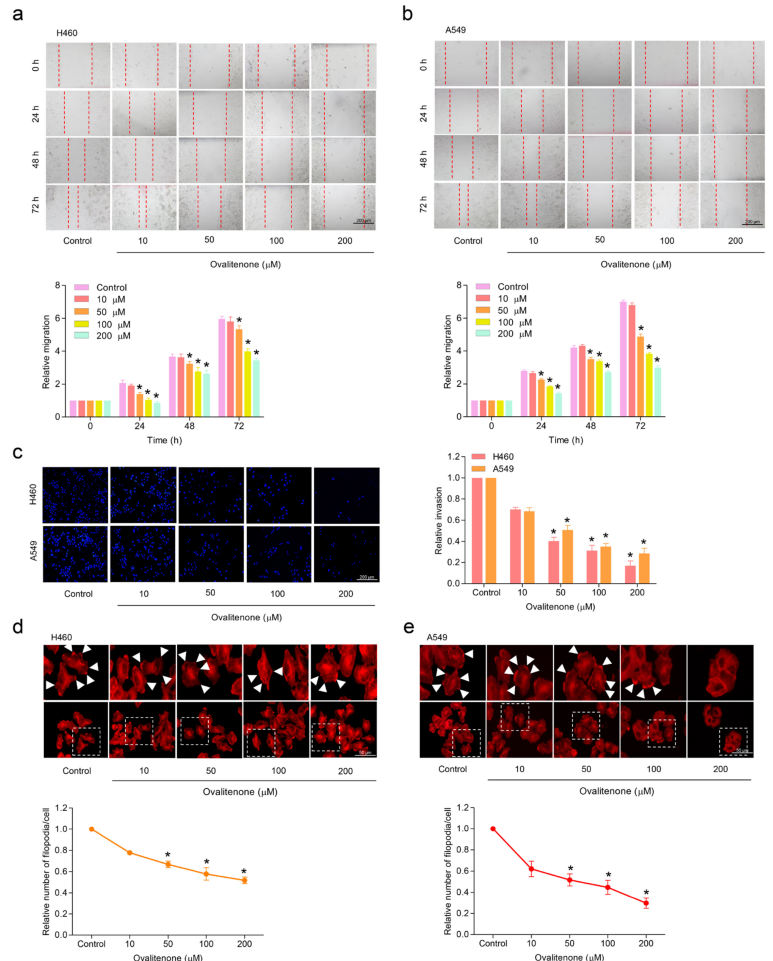
Figure 2. Ovalitenone suppresses cell migration, invasion and filopodia formation. ( a , b ) Cells were treated with ovalitenone for 24, 48, and 72 h, and migration activity was determined by wound healing assay. ( c ) Cell invasion was examined by transwell invasion assay. After 24 h, invading cells were stained with Hoechst 33342 and photographed. ( d , e ) Cells were treated with ovalitenone for 24 h, filopodia was stained with phalloidin-rhodamine, and the number of filopodia per cells was counted. All data are represented as mean ± SEM ( n = 3). * p < 0.05 compared with untreated